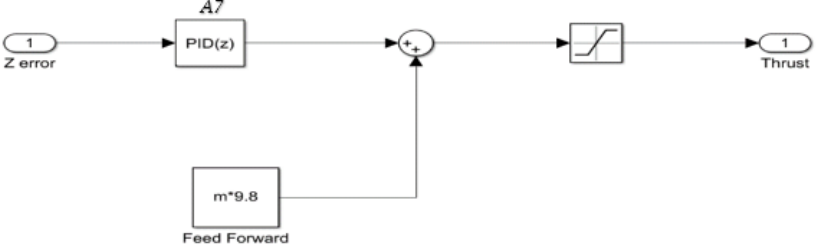
Figure 10. The PID controller controls Z.